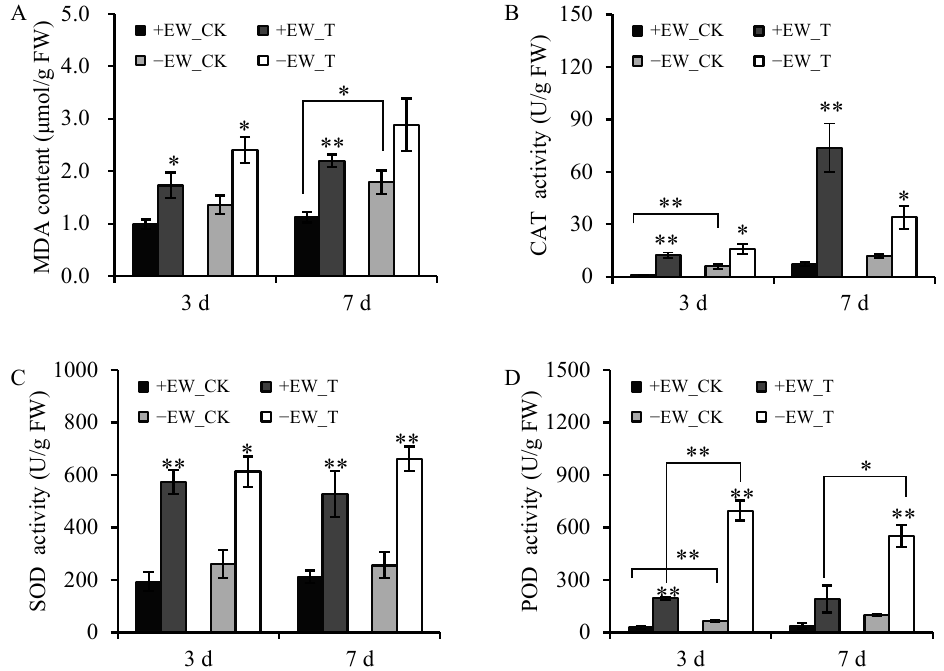
Figure 3. The MDA content ( A ), CAT activity ( B ), SOD activity ( C ), and POD activity ( D ) influenced by Colletotrichum sublineola infection in sorghum leaves, with water as control. Bars with one star (*) or two stars (**) are significantly different at p ≤ 0.05 or p ≤ 0.01, by a one-way analysis of variance with Duncan’s multiple range test, respectively. Values are means ± SE ( n = 6).